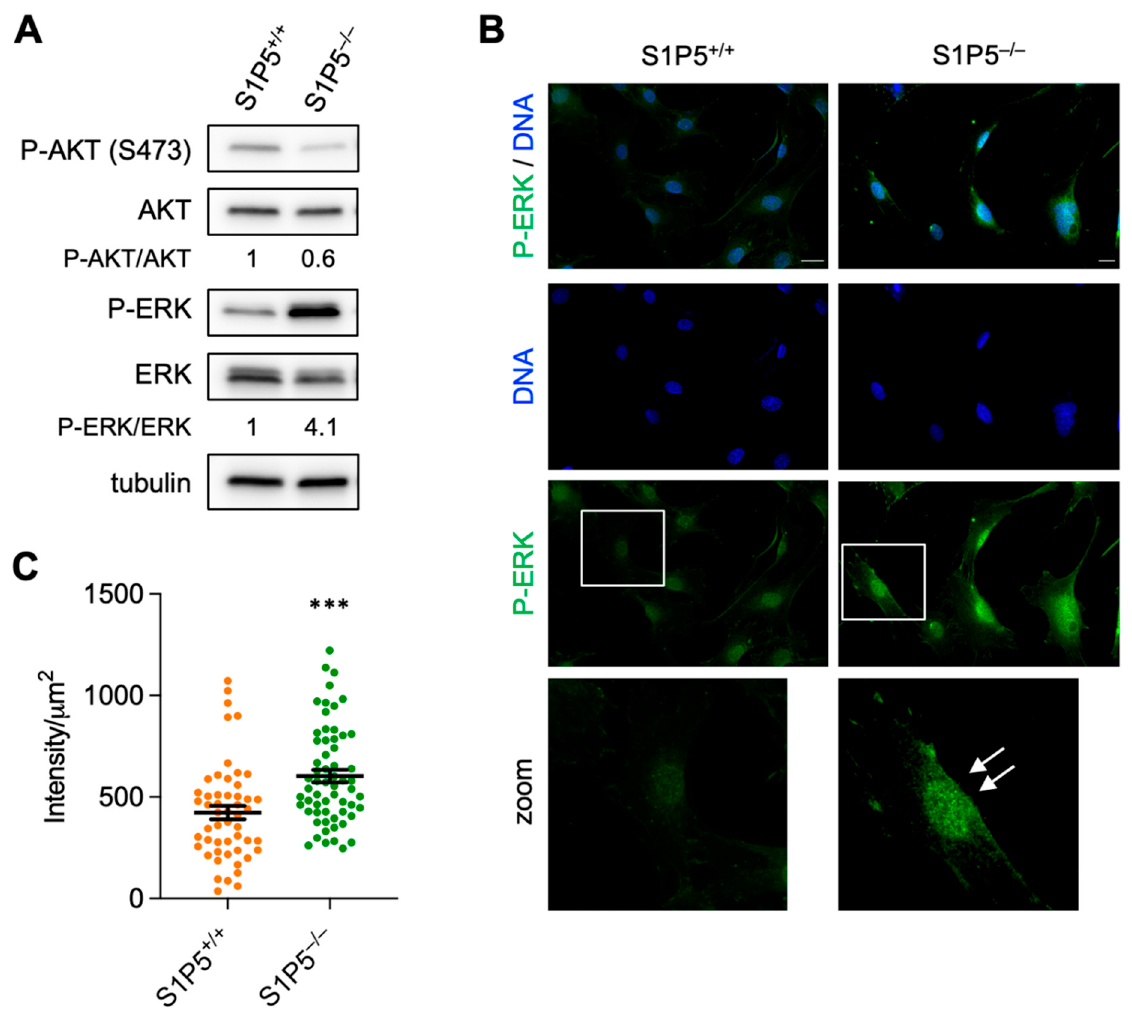
Figure 8. S1P5 reduces nuclear P-ERK localization. ( A ), S1P5 +/+ and S1P5 − / − cells were grown in medium containing 10% FBS for 24 h. Total cell extracts were analyzed by SDS/PAGE with antibodies against the indicated proteins. ( B ), S1P5 +/+ and S1P5 − / − MEFs were cultured as in ( A ), fixed and stained for phospho-ERK (a-ERK-green), DNA (Hoechst 33,342-blue) and actin (phalloidin-red). Representative images are shown in the upper panel. Scale bar: 10 µ m. ( C ), quantification of nuclear phospho-ERK staining based on anti-ERK and Hoechst 33,342 staining. Images were taken with a 20 × objective and the same exposure settings were used for all fluorescence quantifications. Results are expressed as fluorescence intensity per μ m 2 (***, p < 0.0001; S1P5 +/+ , 423.3 ± 33.30, n = 52; S1P5 − / − 603.6 ± 30.77, n = 61).